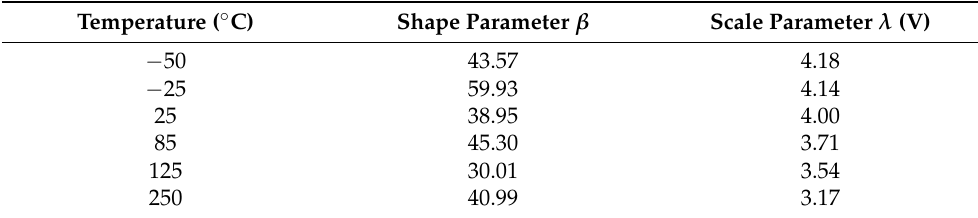
Table 1. Weibull distribution parameters for forming voltage of investigated RRAM devices at various temperatures.